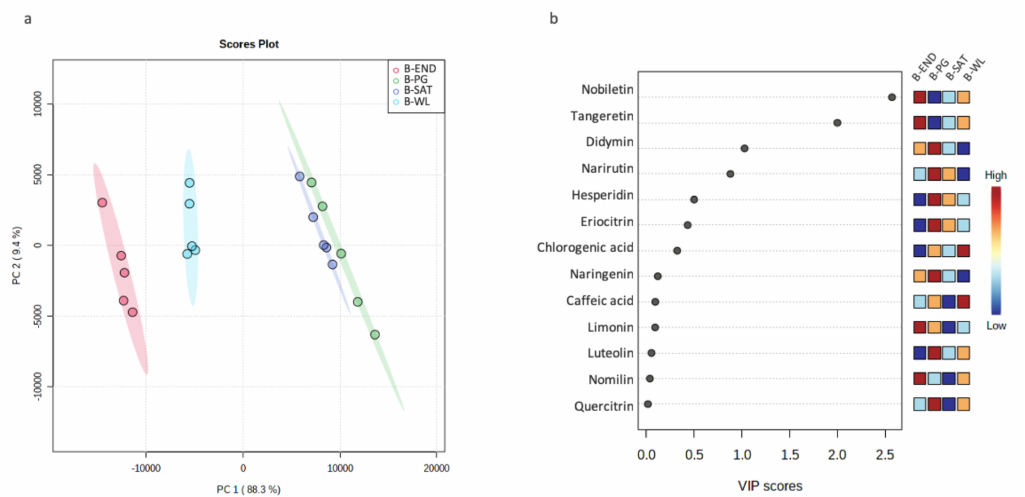
Figure 2. ( a ) PCA plot of the four varieties of mandarin leaf at a bearing stage ‘Ellendale’ (B-END), ‘Willowleaf’ (B-WL), ‘Page’ (B-PG), and ‘Satsuma’ (B-SAT); ( b ) VIP scores of the PLS-DA performed over the four varieties of bearing mandarin leaves.